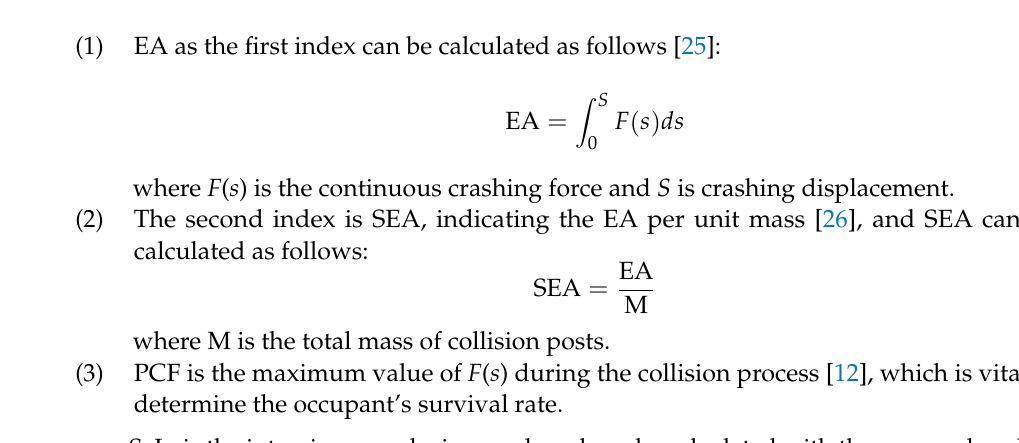
Figure 4. Experimental setup: ( a ) test trolley; ( b ) measurement devices; ( c ) crash location; ( d ) test article